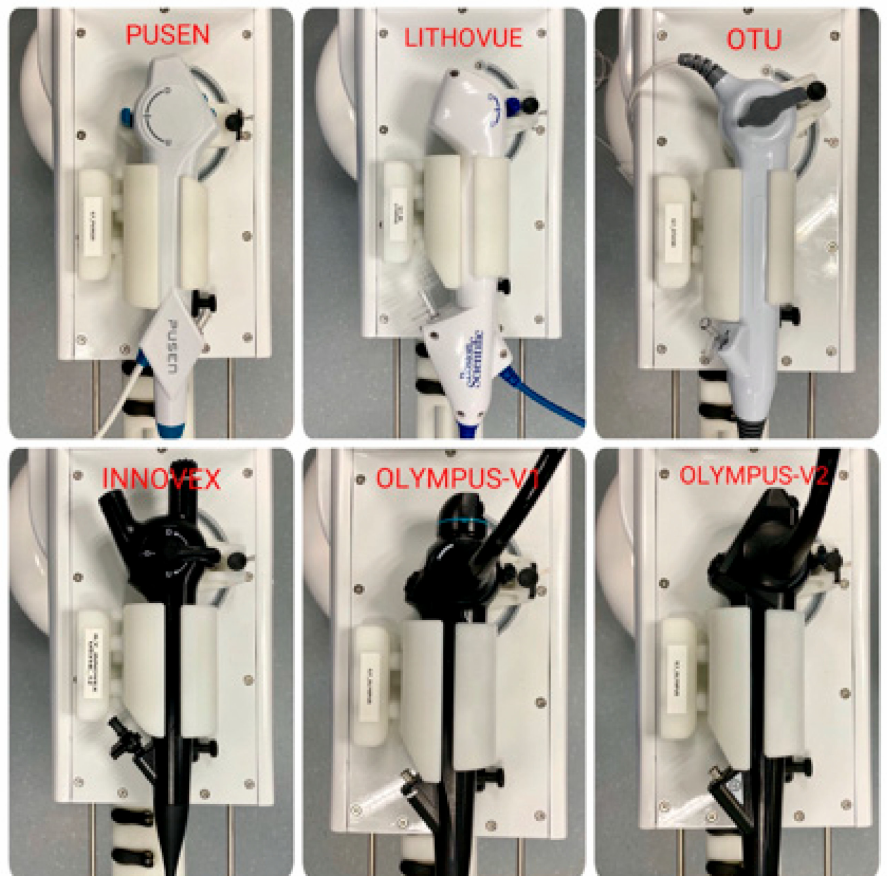
Figure 7. The ILY ® ureteroscope holder is compatible with all types of ureteroscopes available on the market (reusable and